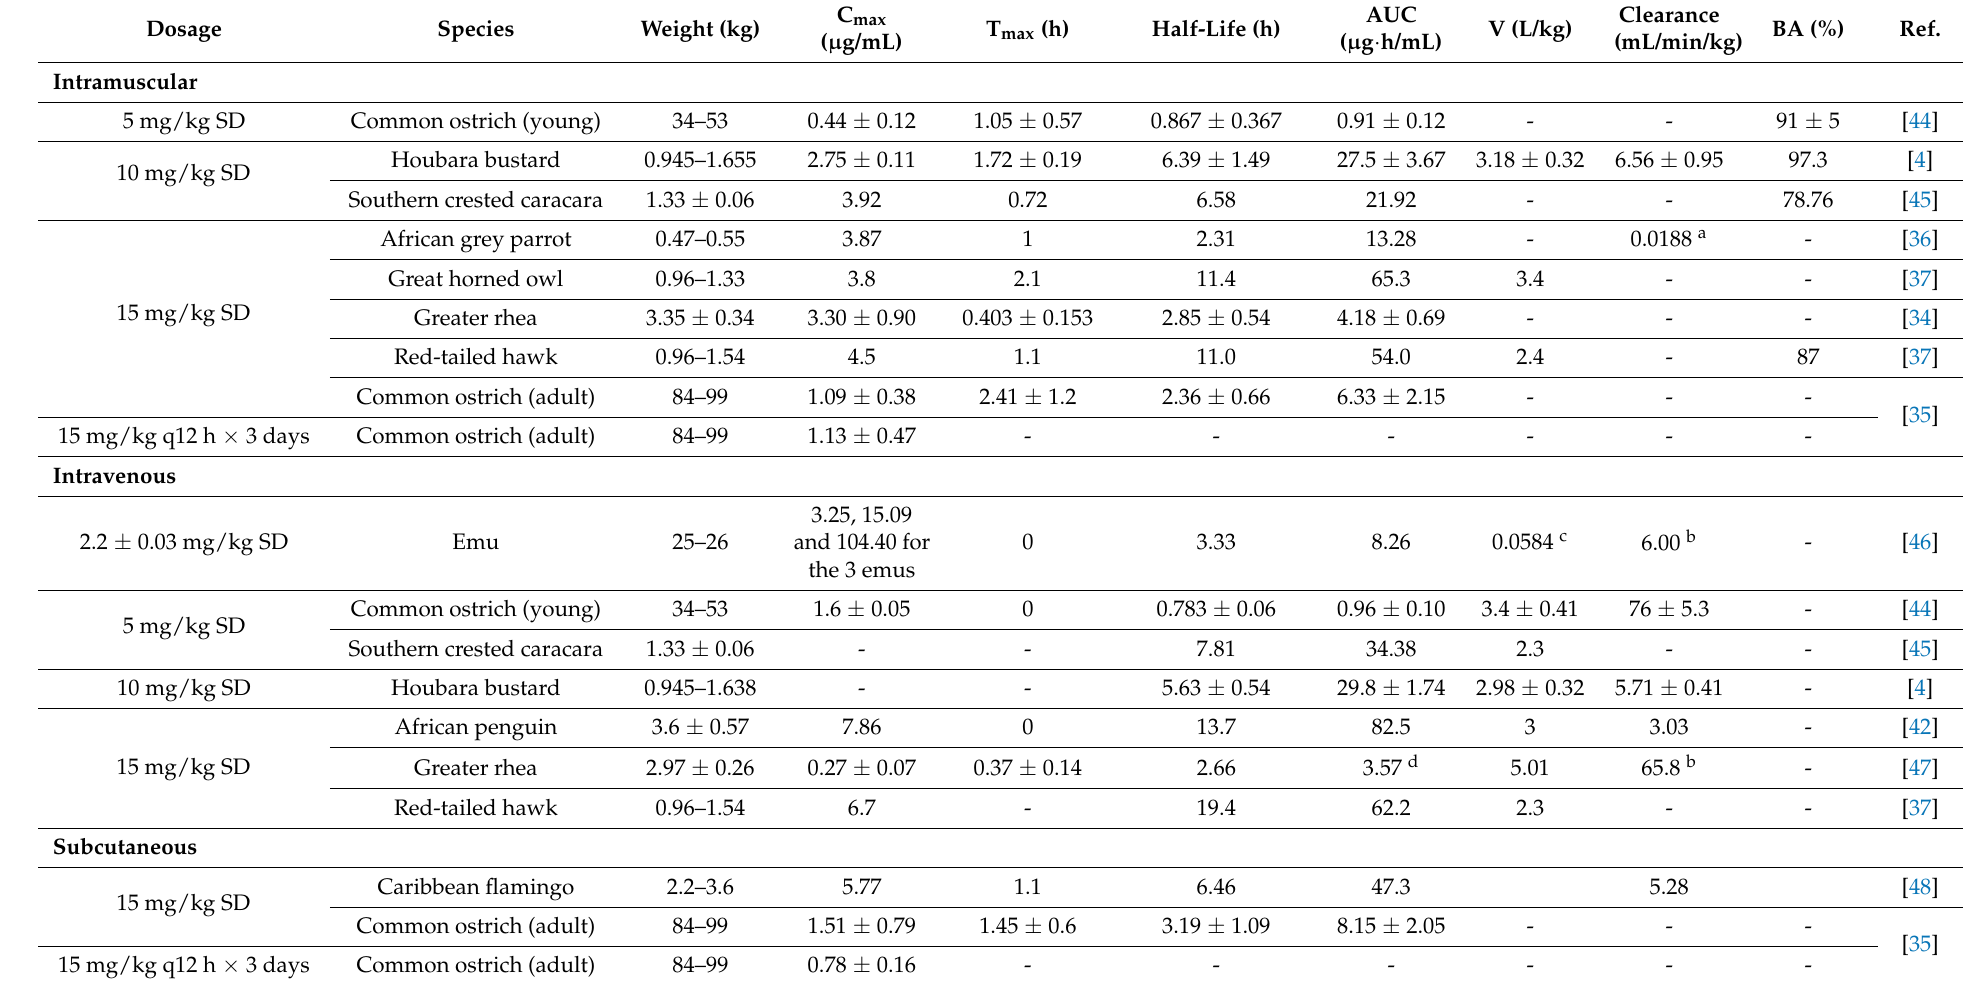
Table 3. Pharmacokinetic values for enrofloxacin in exotic avian